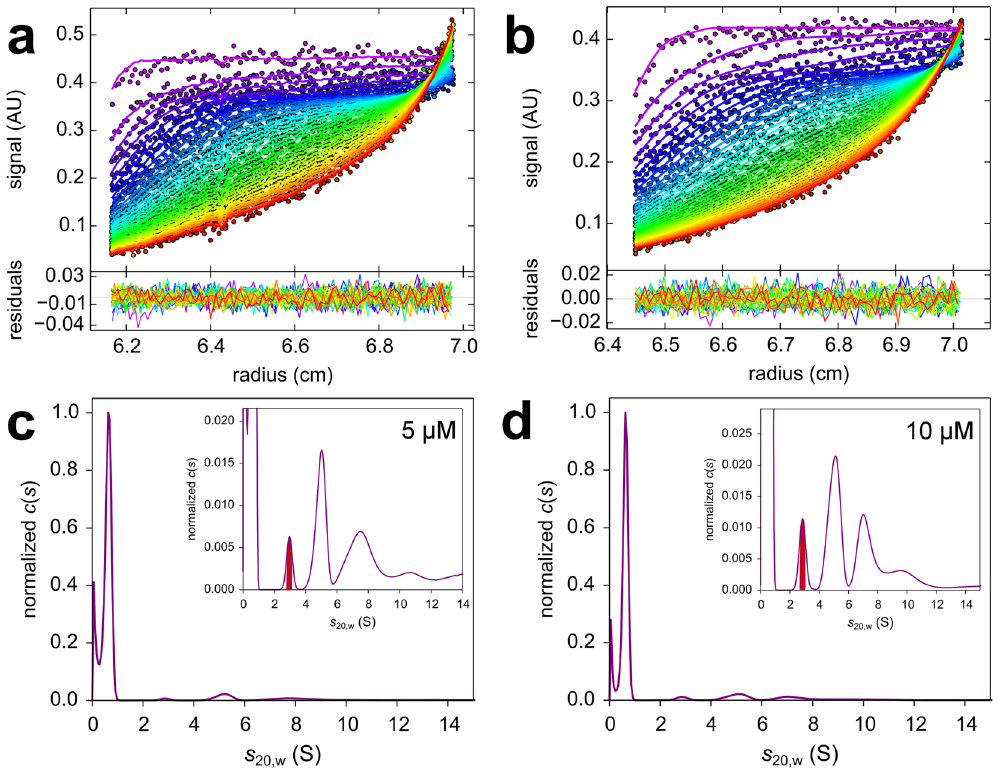
Figure 2. The SV analysis at low micromolar A β 42 concentrations yields the existence of the small oligomer between 2 S and 3 S and a fraction of larger assemblies with s -values between 3 and 12 S. The raw data at 5 µ M ( a ) and 10 µ M A β 42 ( b ) together with overlaid fit results and residuals are shown. The corresponding c ( s ) results for 5 µ M ( c ) and 10 µ M A β 42 ( d ) are shown below. Sedimentation was performed at 50,000 rpm, 20 °C and monitored with absorbance detection. Detection wavelength for 5 µ M was 208 and 220 nm for 10 µ M A β 42. The c ( s ) distribution was normalized to a maximum c ( s ) value. The insets show the distributions with an expanded y